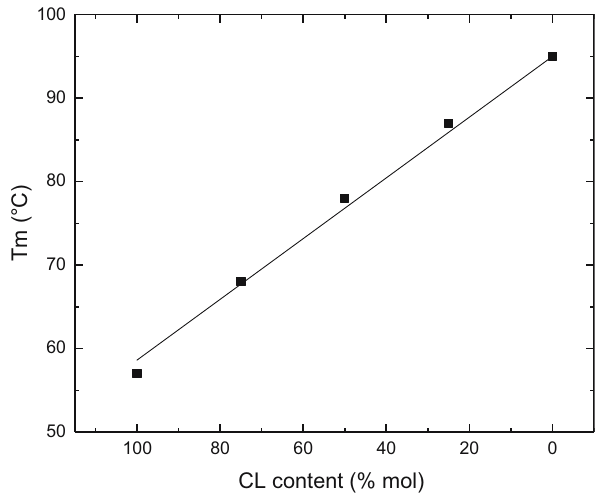
Figure 6: Relationship between T m and ε - caprolactone ( ε - CL ) con - tent in CL – PDL copolymers.